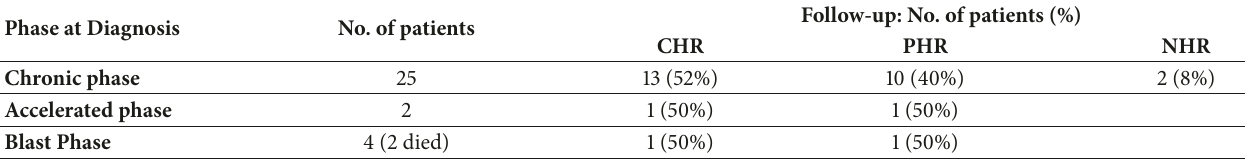
Table 2: Hematological